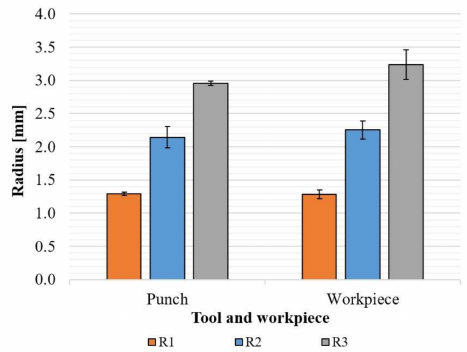
Figure 10. Average radius of workpiece over five strokes and of punches with different nose